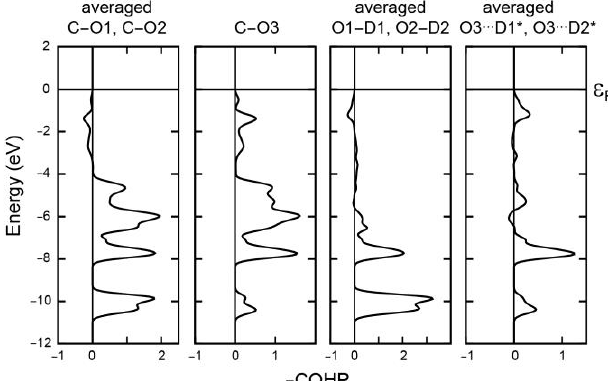
Figure 5. Projected Crystal Orbital Hamilton Populations (COHP) of the bonds in solid-state carbonic acid. The plots indicate bonding/antibonding levels going to the right/left, in particular C–O “single” ( far left ), C=O “double” ( left ), O–D single ( right ) and hydrogen-bridging bonds ( far right ). The Fermi level has been set to zero.